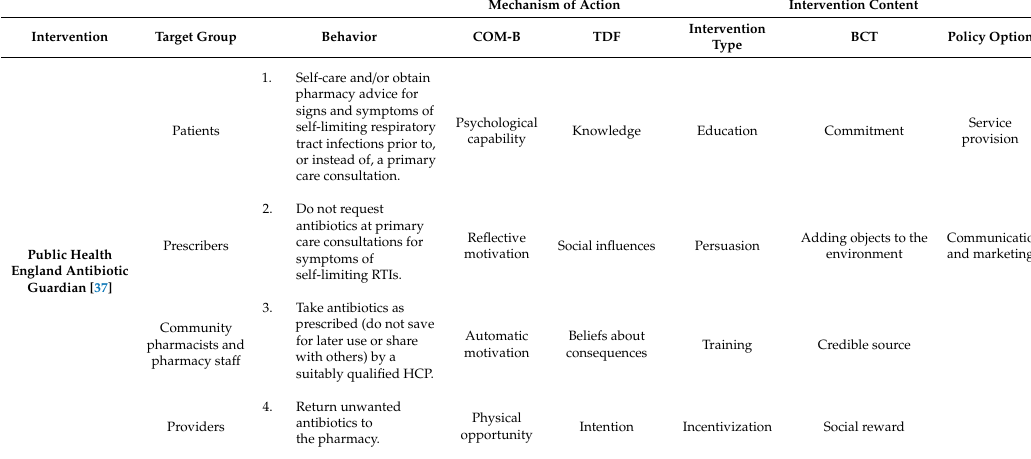
Table A1. Summary of intervention, target group, behavior, mechanism of action, and intervention